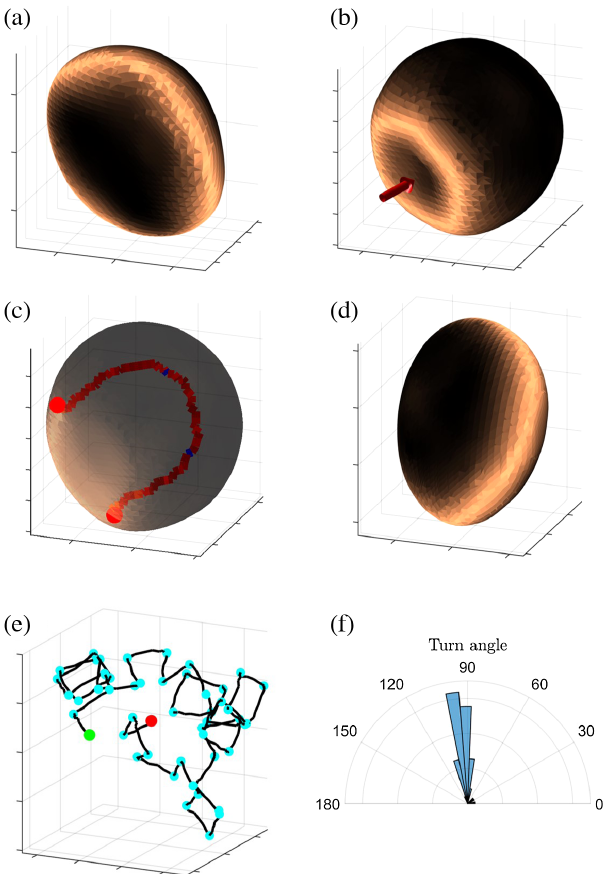
plane alignment, dimples and valleys are driven into the drop